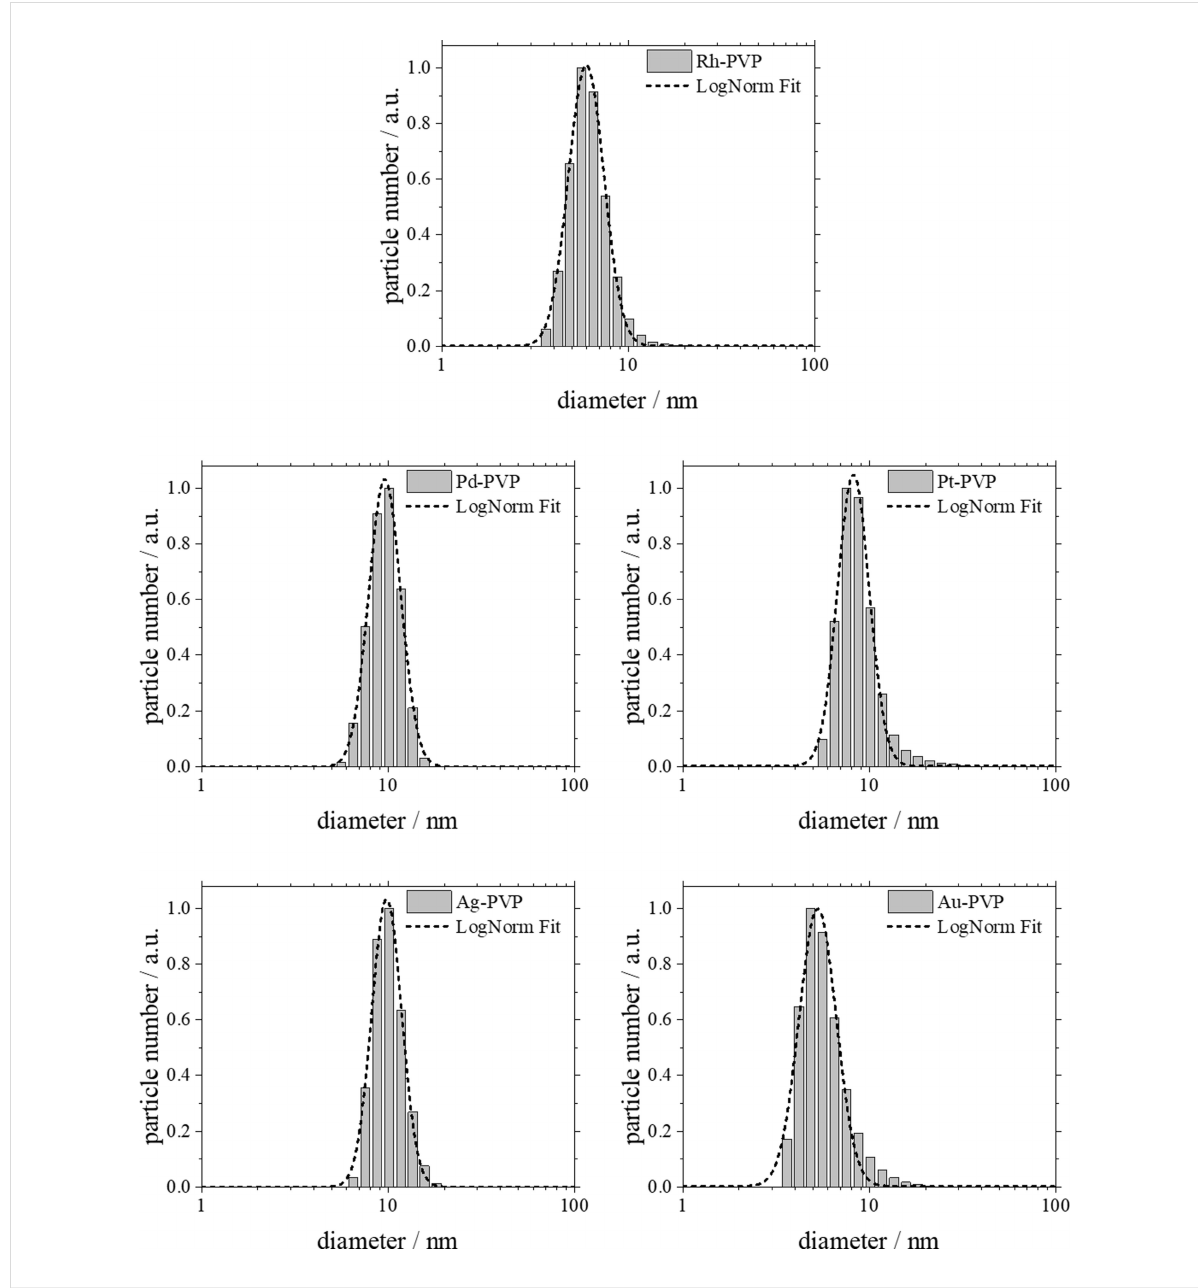
Figure 1: Particle size distribution of PVP-stabilized noble metal nanoparticles determined by dynamic light scattering (DLS). All data are given as size by number and are normalized for better comparison. The polydispersity index (PDI) was between 0.1 and 0.3 in all cases.